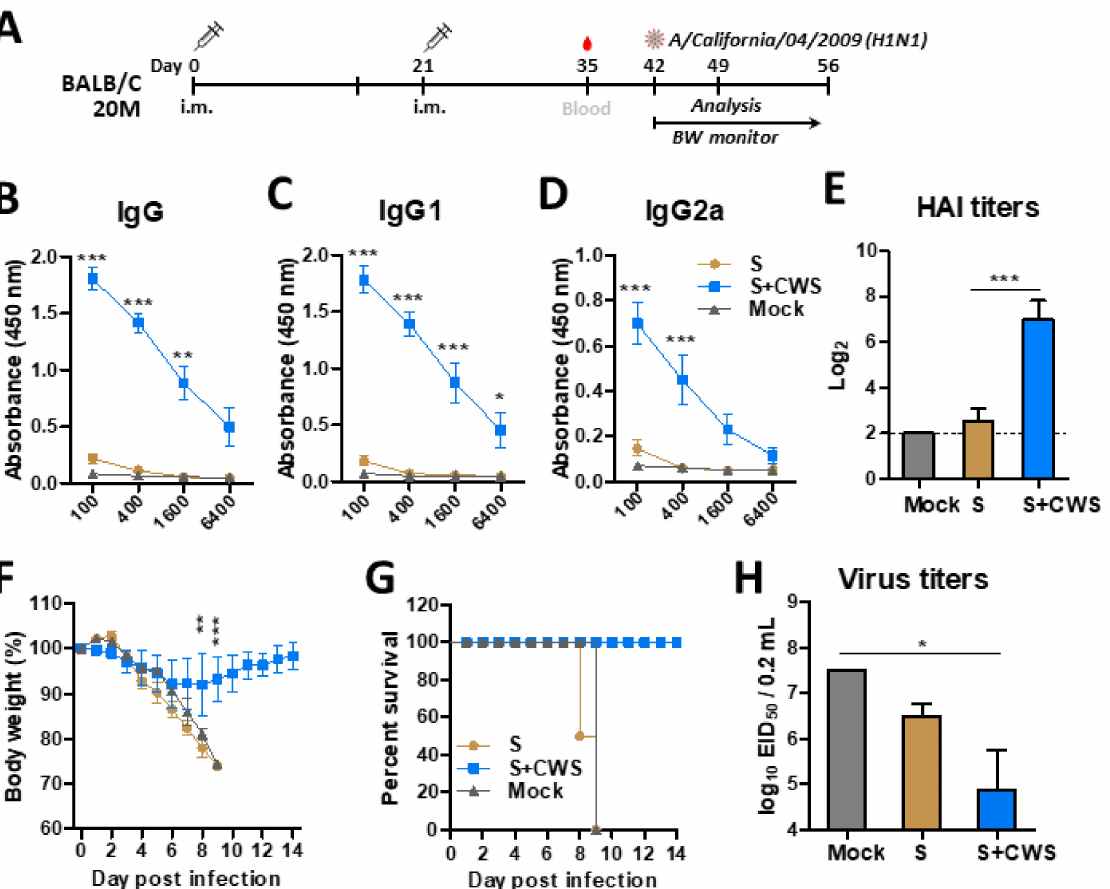
Figure 5. BCG-CWS adjuvant effects on enhancing IgG, HAI, and protective efficacy in vaccinated aged (20 M) mice. ( A ) Immunization and challenge schedule. The groups of aged (20 M) mice ( n = 10) were i.m. twice immunized with sCal (S) or S+CWS (CWS: BCG-CWS) at a 3-week interval. ( B – D ) Serum IgG, IgG1, IgG2a specific for virus antigen in boost sera. ( E ) HAI titers against A/Cal virus in boost sera. ( F , G ) Weight changes and survival rates after lethal dose A/Cal virus infection in aged (20 M) mice ( n = 5). ( H ) Lung viral titers ( n = 5) at 7 dpi. Statistical significance was calculated by using one- or two-way ANOVA and a Bonferroni’s multiple-comparison test. Error bars indicate the mean ± SEM. *; p < 0.05, **; p < 0.01, ***; p <